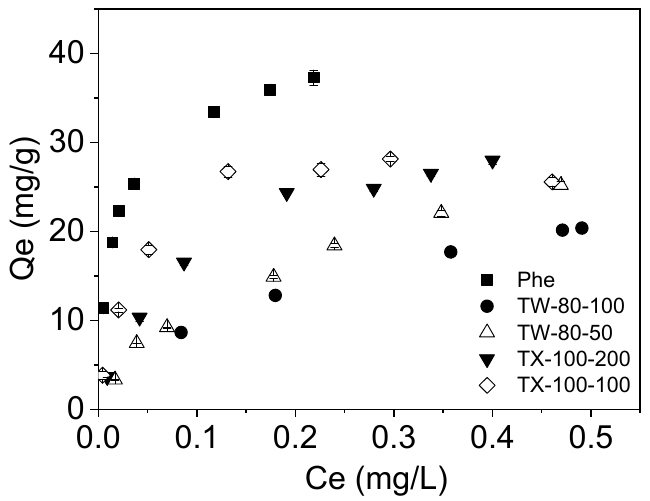
Figure 3. Adsorption isotherms of phenanthrene onto MWCNTs affected by nonionic surfactants. Table 3. Langmuir and Freundlich and dual model parameters for the adsorption of surfactants and Phe onto MWCNTs under TW-80 and TX-100 conditions.